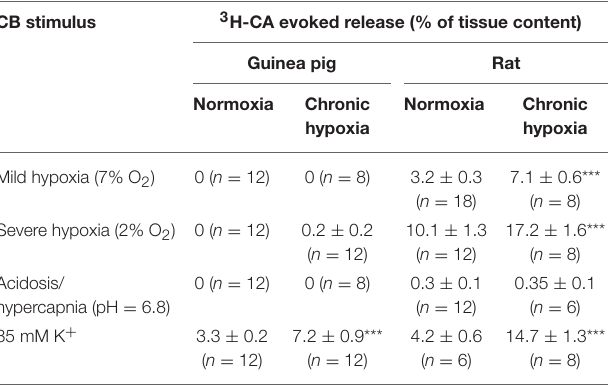
TABLE 3 | Normoxia (air) and chronic hypoxia (10–12% O 2 ; 15 days) 3 H-CA release response from guinea pig and rat CB induced by different natural stimuli and high extracellular K +